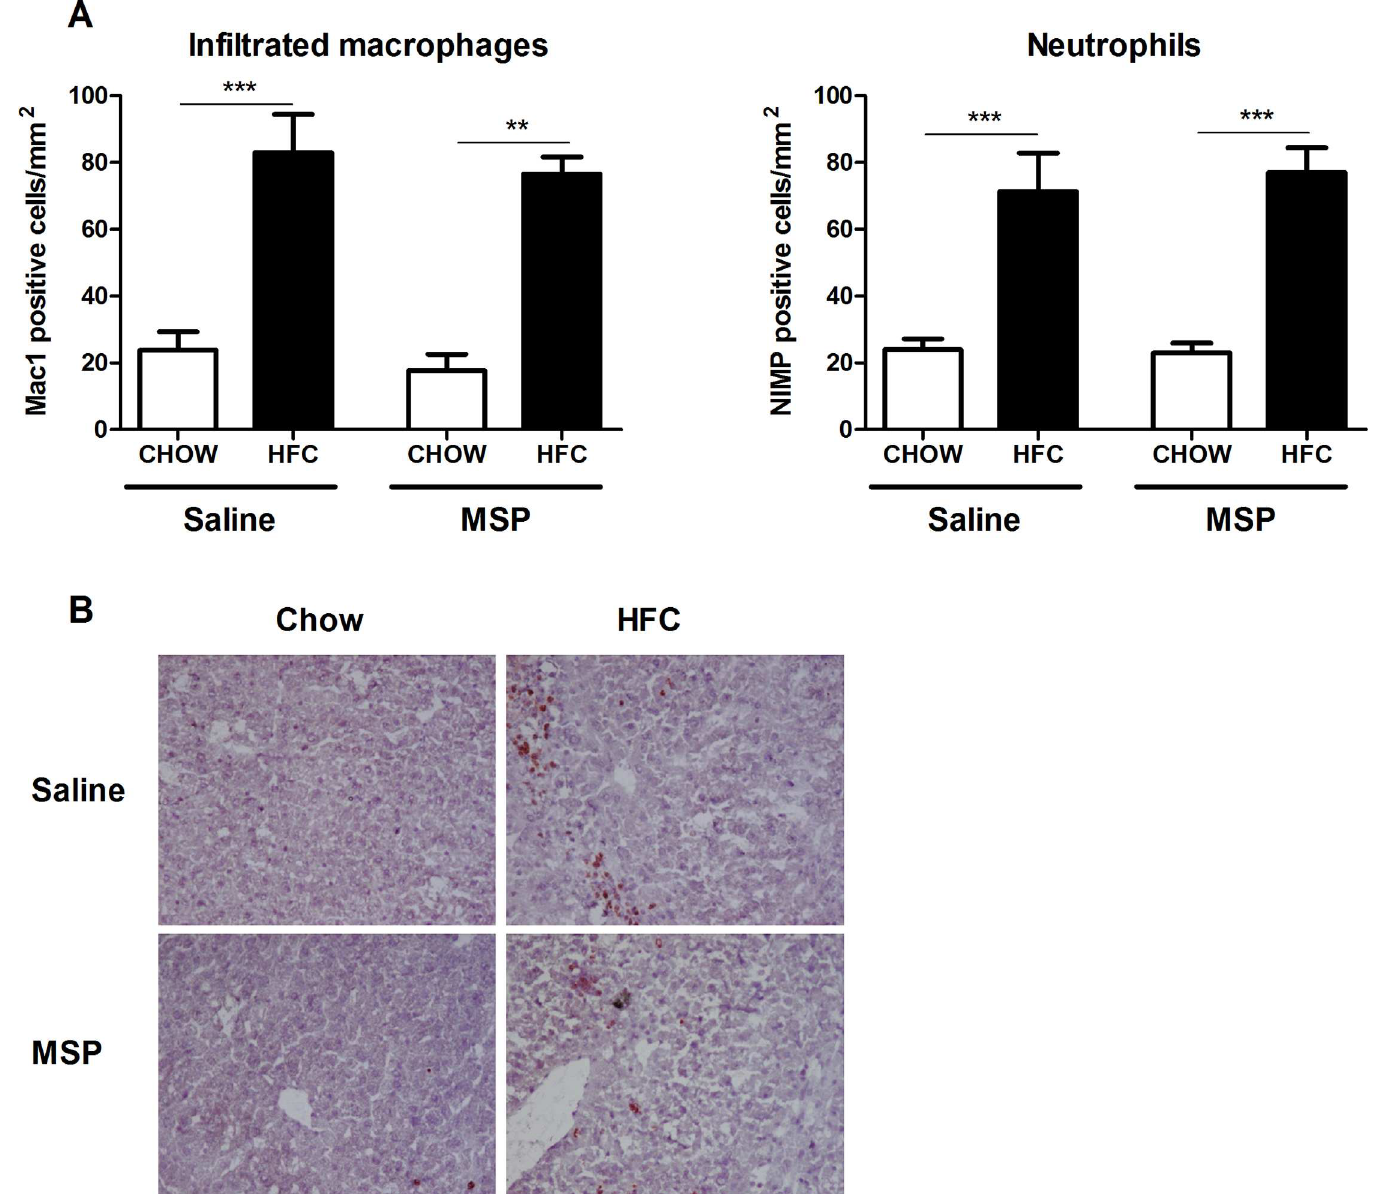
Fig 3. Parameters of macrophage and neutrophil infiltration in the liver. (A) Liver sections were stained for infiltrating macrophages and neutrophils, respectively. Positive immune cells were counted. (B) Representative images of the Mac1 staining (200 × magnification) after one week of regular chow or HFC diet in Ldlr -/- mice, with and without MSP treatment. Data are represented as mean ± SEM. ** and *** indicate significant differences between groups, with ** p < 0.01 and *** p <